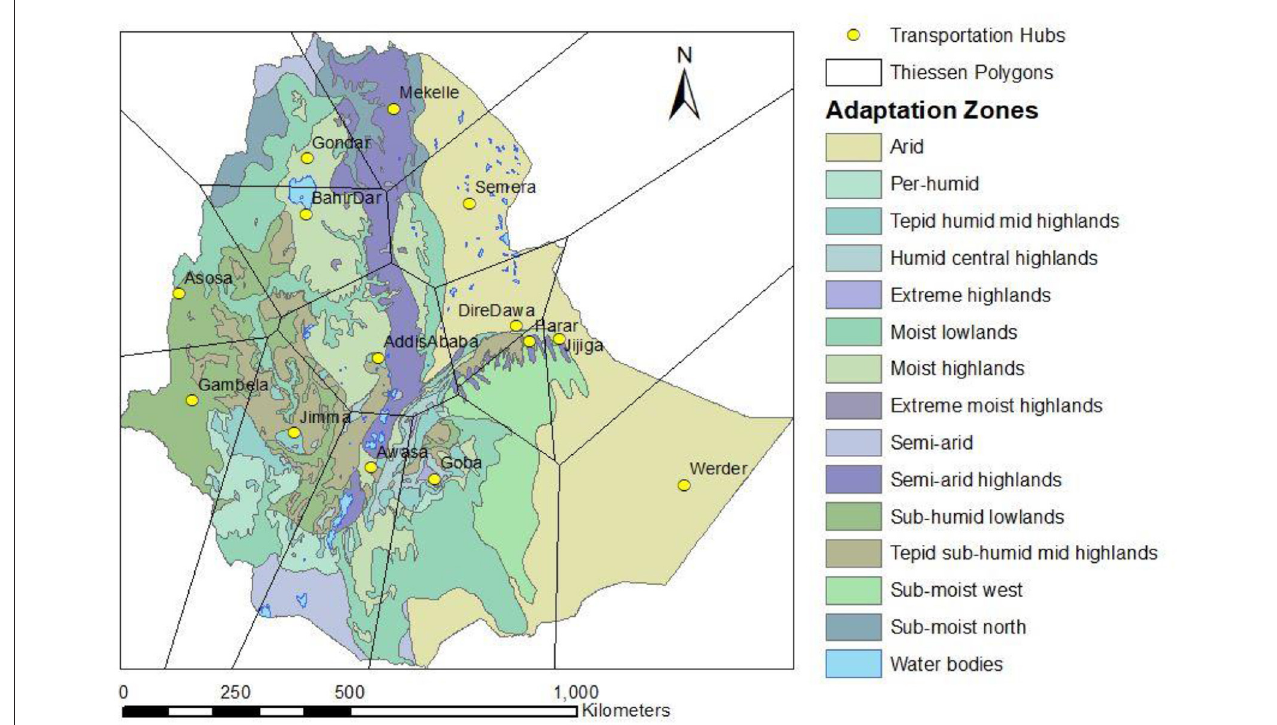
FIGURE 1 | Adaptation zones of Ethiopia and regions centered around transportation hubs or food markets. Based on Deribew et al.